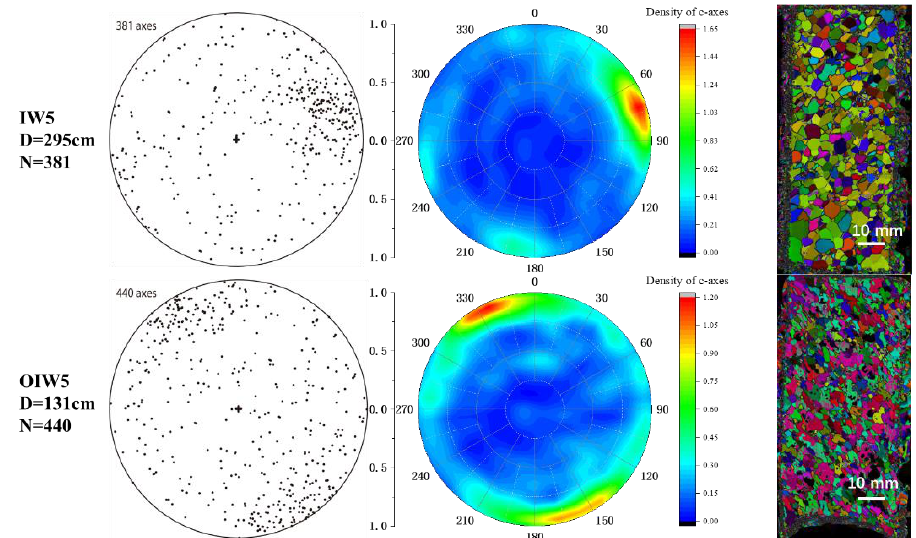
Figure 3. ( a ) The Schmidt diagrams (equatorial projections of c -axis orientations), each point repre- sents the c -axis orientation of each grain; ( b ) the kernel contour maps of c -axis orientations of ice, the density of c -axes represents the strength of the fabric; ( c ) the microstructure maps with colored orientations of each grain, the legend of the map is shown in the color wheel at the top left of Figure 3. The left side shows the basic information for each thin section, including sample number, depth (D), and number of c -axis (N), one c -axis per grain.